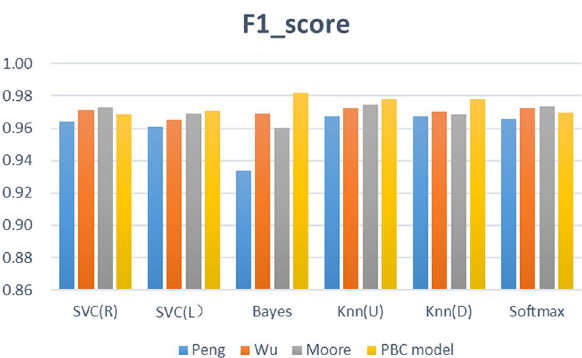
Figure 10. F1-score of the four types of prediction models.